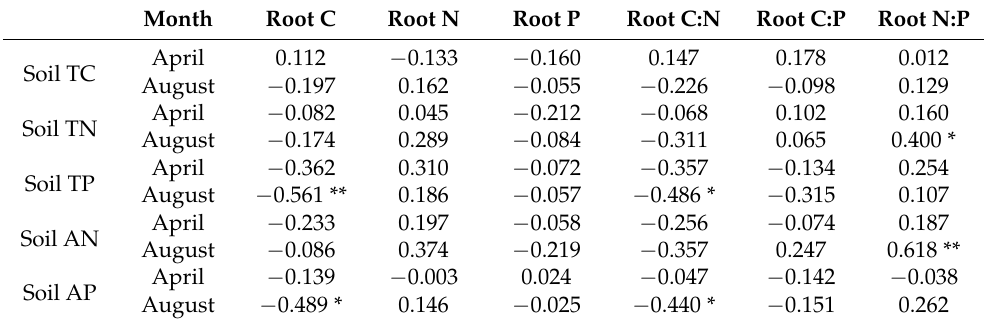
Table 2. Standardized Coefficients between soil nutrients and root C, N, P, C:N, C:P, and N:P. Month Root C Root N Root P Root C:N Root